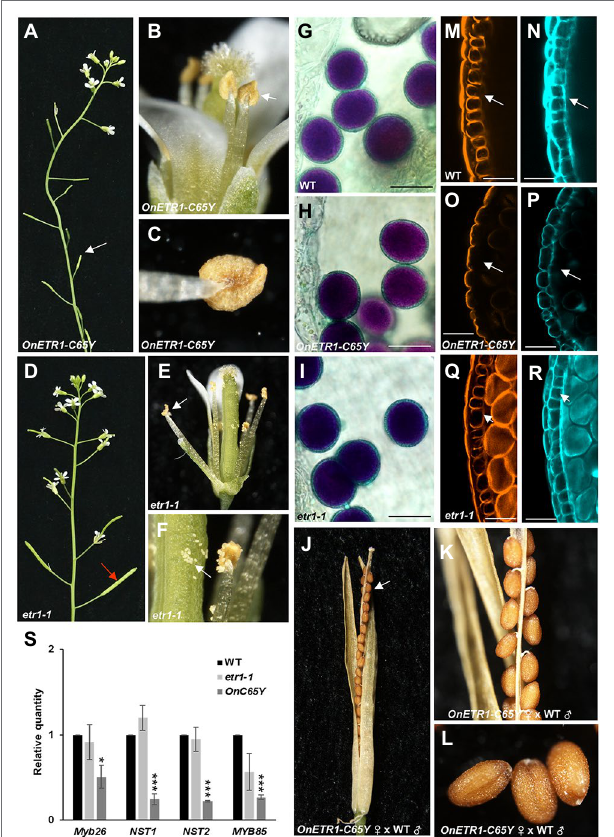
FIGURE 7 | Analysis of the indehiscent anther phenotype and the detection of gene expression in 35S:: OnETR1 - C65Y Arabidopsis . (A) Inflorescence of a 35S:: OnETR1 - C65Y plant showing short siliques (arrow). (B) A 35S:: OnETR1 - C65Y flower with an indehiscent anther (arrow). (C) Close-up view of an indehiscent anther from (B) . (D) Inflorescence of an etr1-1 mutant with elongated siliques (arrow). (E) An etr1-1 flower with a dehiscent anther (arrow). (F) Close-up view of a dehiscent anther and released pollen (arrow) from (E) . (G–I) Pollen grain viability analysis of 35S:: OnETR1 - C65Y male-sterile anthers via Alexander staining. Wild-type (G) , 35S:: OnETR1 - C65Y (H) , and etr1-1 (I) Arabidopsis had similar viable pollen grains with similar shapes. Bar = 20 μ m. (J) The normal elongated silique and normal seeds (arrow) of a 35S:: OnETR1 - C65Y plant after pollination with wild-type pollen. (K,L) Close up of the normal seeds in the silique from (J) . (M–R) CLSM of anther cell walls in wild-type (M,N) , 35S:: OnETR1 - C65Y (O,P) , and etr1-1 (Q,R) Arabidopsis . The anthers were double stained with auramine O for lignin, indicated in orange (M,O,Q) , and with calcofluor white for cellulose, indicated cyan (N,P,R) . Secondary thickening is visible in the endothecium (arrowed) of the wild-type (M,N) and etr1-1 (Q,R) anthers but is absent in 35S:: OnETR1 - C65Y (O,P) anthers (arrowed). Bar = 25 μ m. (S) mRNA levels as determined via real-time quantitative PCR. Total RNA isolated from wild-type, etr1-1 and 35S:: OnETR1 - C65Y plants was used as a template to detect the expression of MYB26 , NST1/2 , and MYB85 . The transcript levels of these genes were determined using two to three replicates and were normalized to UBQ10 . The expression of each gene in the transgenic plants is given relative to that of the wild-type plant, which was set at 1. The error bars represent SDs. The asterisks indicate a significant difference from the WT value (* p < 0.05 and *** p < 0.001). Statistical analysis was conducting using two-tailed Student’s t